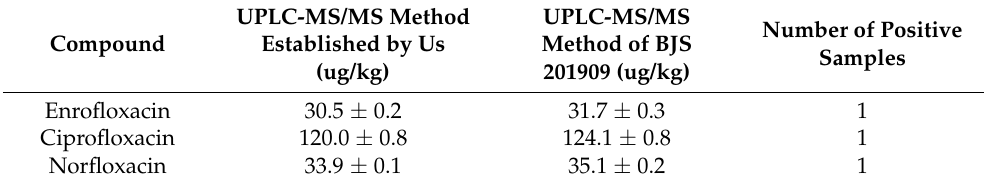
Table 2. Comparison and verification of the two analysis